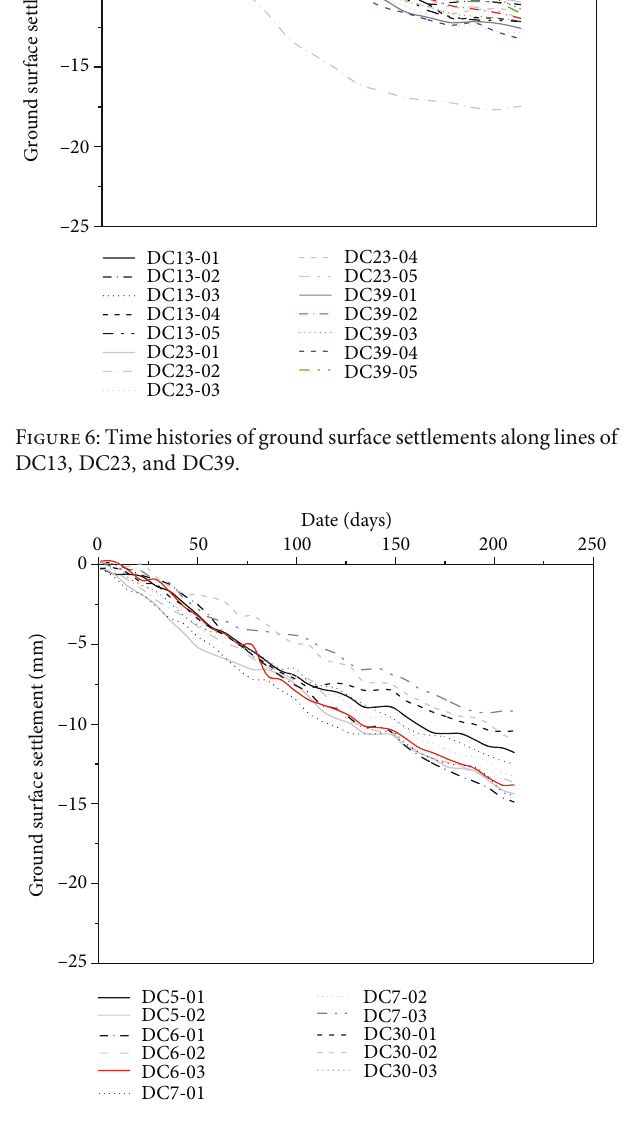
Figure 7: Time histories of ground surface settlements along lines of DC05, DC06, DC07, and DC30.